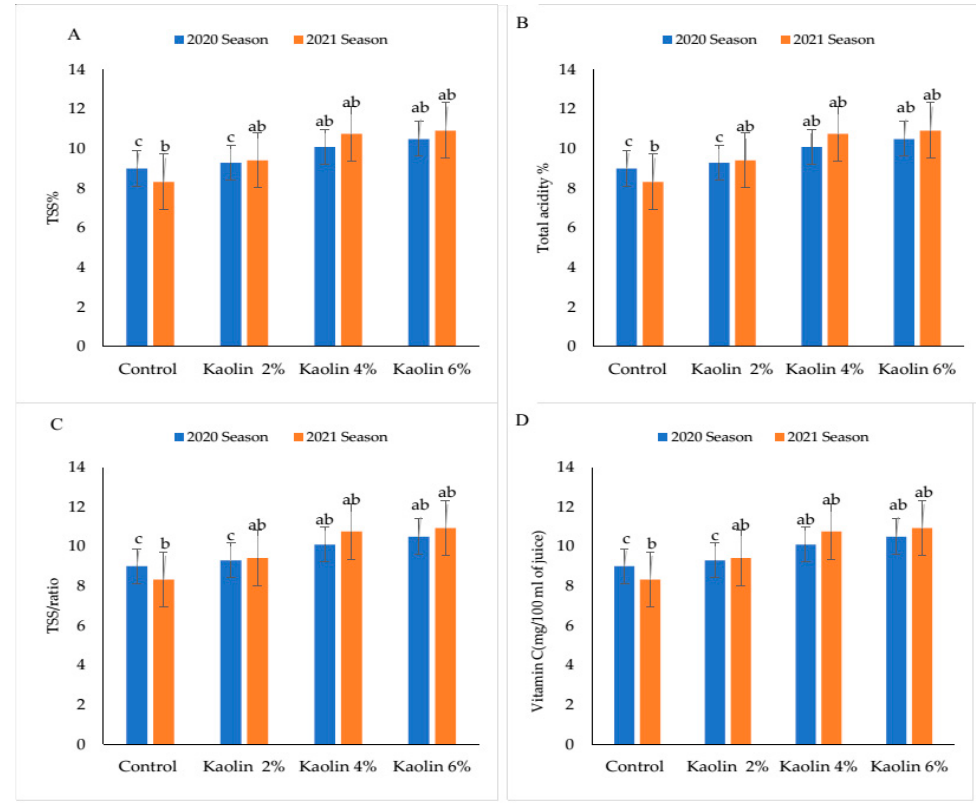
Figure 11. Effect of kaolin spray on: ( A ) TSS (%), ( B ) total acidity (%), ( C ) TSS/acid ratio and ( D ) vitamin C (mg/100 mL of juice) of Keitt mango cultivar during the seasons 2020 and 2021. Bars indicate mean values ± SE (n = 9). Different letters above columns indicate significant differences among pruning treatments at p = 0.05 according to Bartlett’s test.